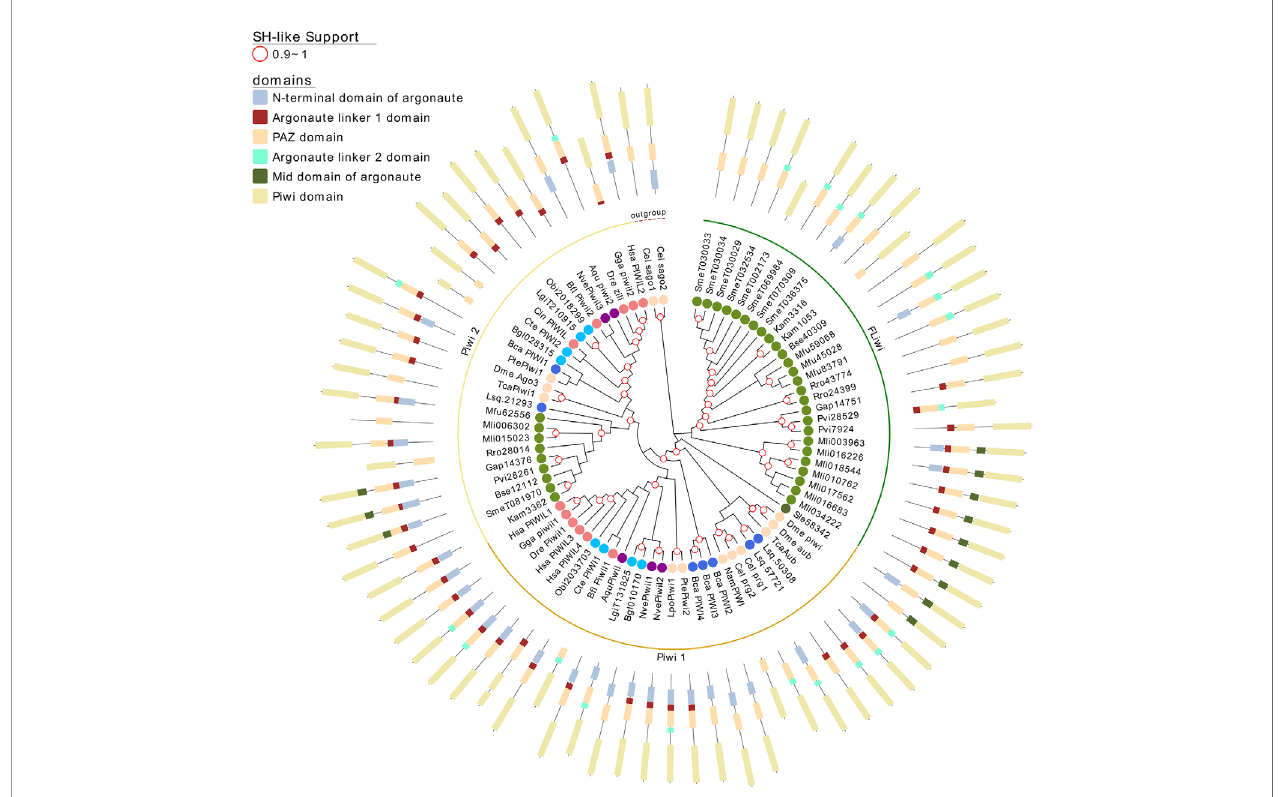
FIGURE 4 | A maximum likelihood tree of Piwi proteins. Wagos were used as outgroup. SH-like approximate likelihood ratios are indicated. Conserved protein domains were predicted with HMMScan. Light green, yellow and green arches corresponds to the cluster of the Piwi 2, Piwi 1 and FLiwis, respectively. Abbreviations are as indicated in Figure 2